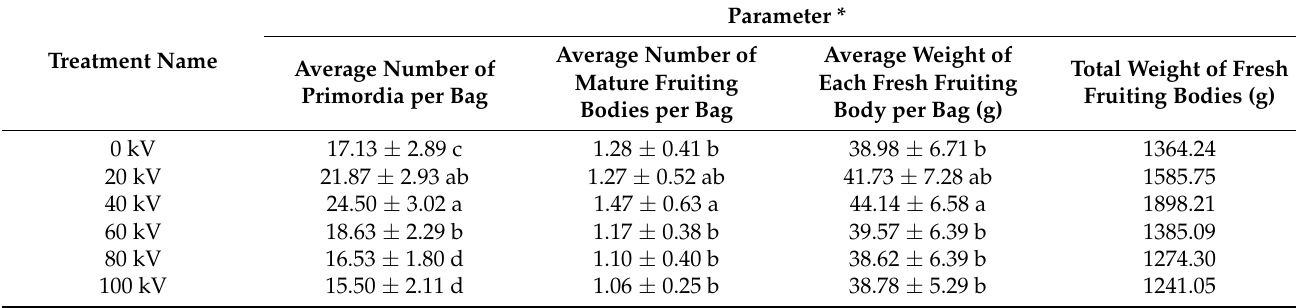
Table 2. Cultivation of P. spongiosus and high-voltage pulsed stimulation.